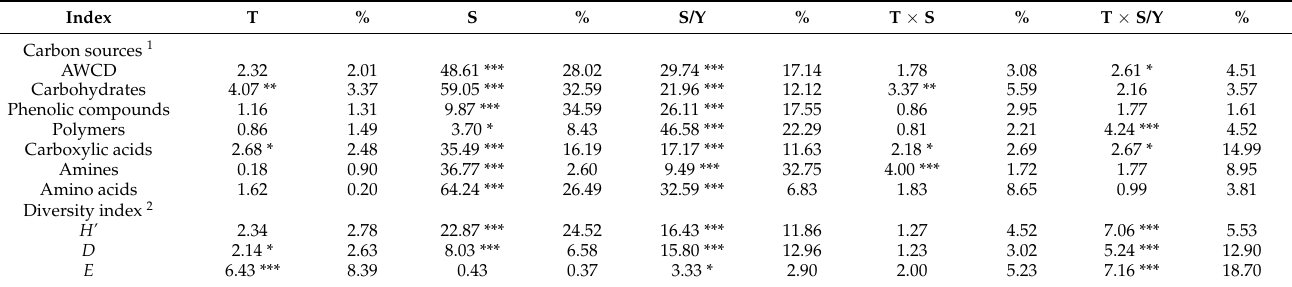
Table 1. The effect of residual treatments (T), study period (S, season; Y, year), and their interaction on the soil physicochemical index and microbial biomass, which were analyzed using repeated nested